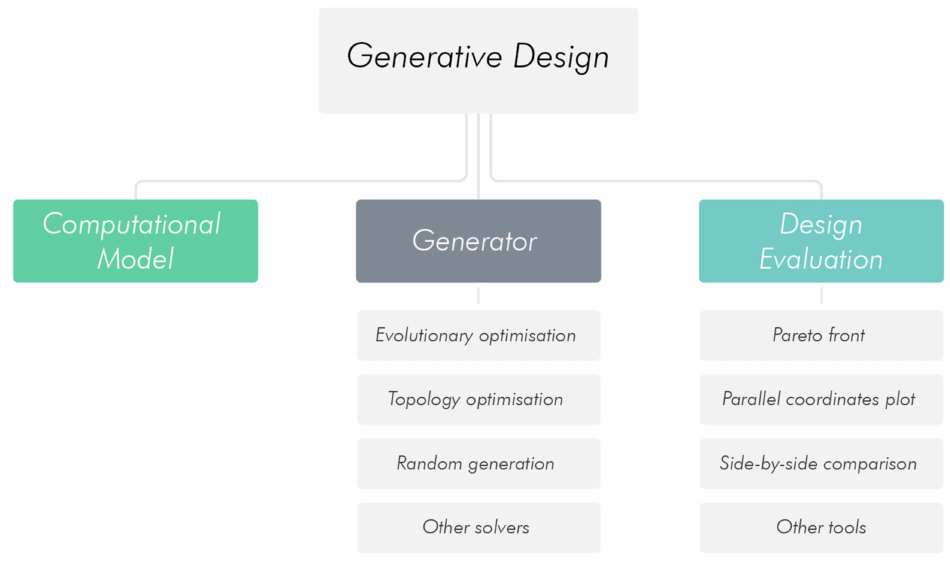
Figure 1. Generative design framework